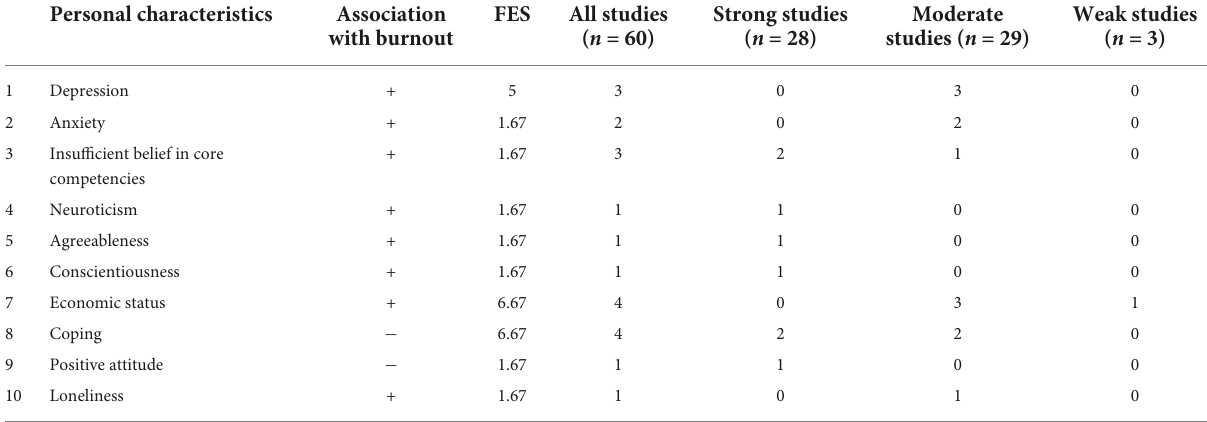
TABLE 5 Study outcomes personal characteristics [ p -values are calculated according to Fisher exact (Freeman and Julious, 2007)]. Personal characteristics